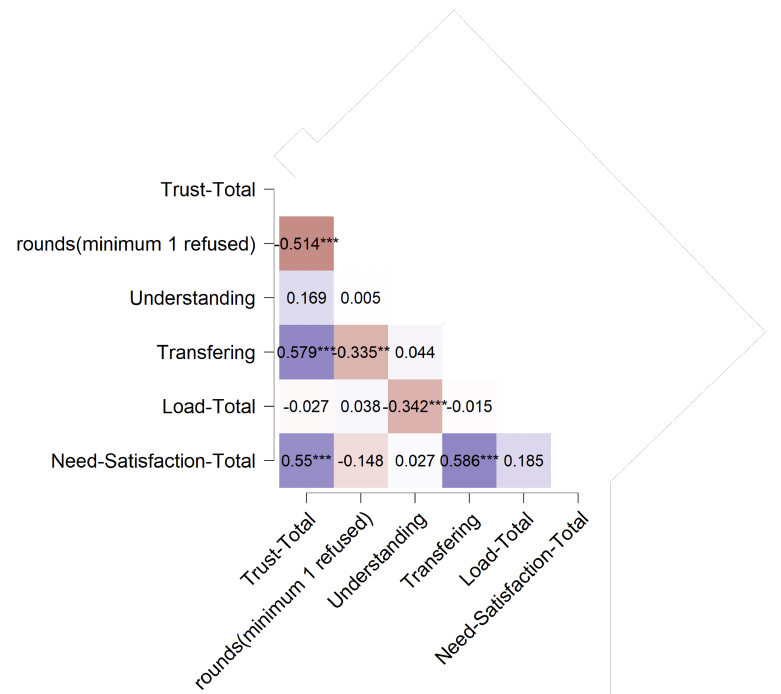
Figure 9. Correlations between the different indicators of ethical (trust and rejection behavior), epis- temic (understanding and transferring), and consumer objectives (workload and need